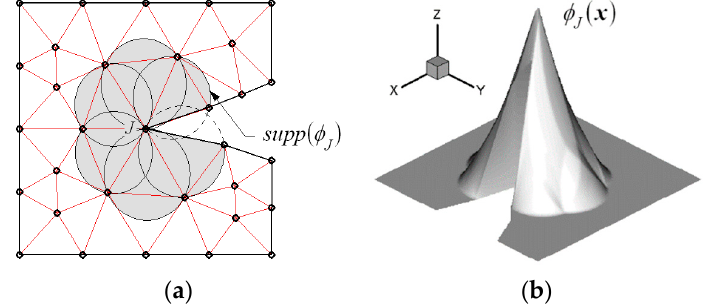
ℑ , ( b ) Laplace interpolation function at the crack Figure 3. ( a ) Non-convex NEM grid Figure 3. ( a ) Non-convex NEM grid (cid:61) NEM , ( b ) Laplace interpolation function φ J ( x ) at the crack NEM tip.